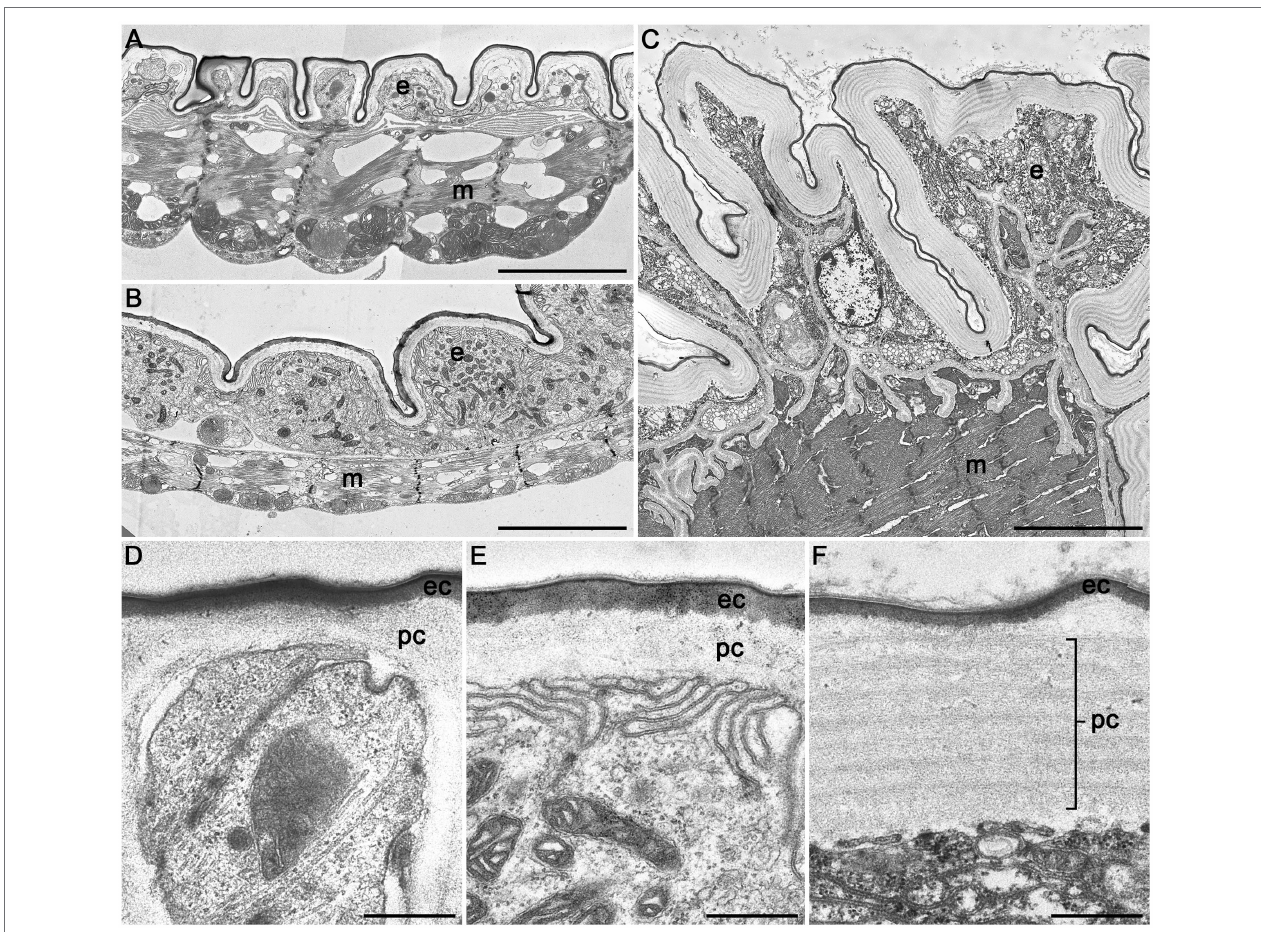
FIGURE 5 | Transmission electron microscopic images of cross sections of the crop of Phyllotreta armoraciae (A,D) , Psylliodes chrysocephala (B,E) , and Phaedon cochleariae (C,F) . A notable difference in overall size is shown in (A–C) (same magnification). A continuous epithelial cell layer (e), muscle layer (m), procuticle (pc), and epicuticle (ec) are visible in all three species. Scale bars are 5 μ m (A–C) and 500 nm (D–F)